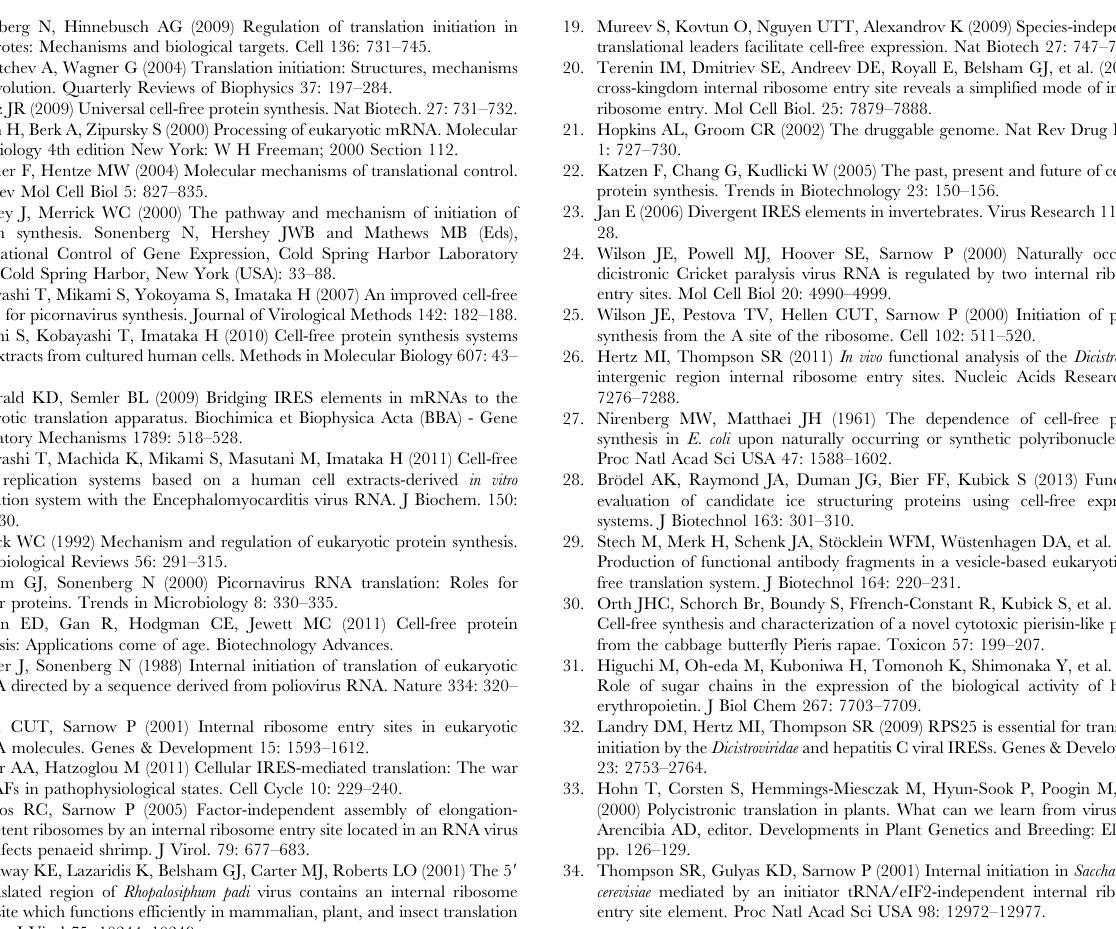
Figure S4 Impact of the cap structure on the expression levels in coupled eukaryotic cell-free systems. (DOCX) Figure S5 Evaluation of optimal KOAc concentration in the wheat germ-based CECF system. (DOCX) Figure S6 Integration of membrane proteins into mi- crosomal vesicles. (DOCX) Table S1 Primer sequences used for DNA template design. Table S2 Expression vectors used in this